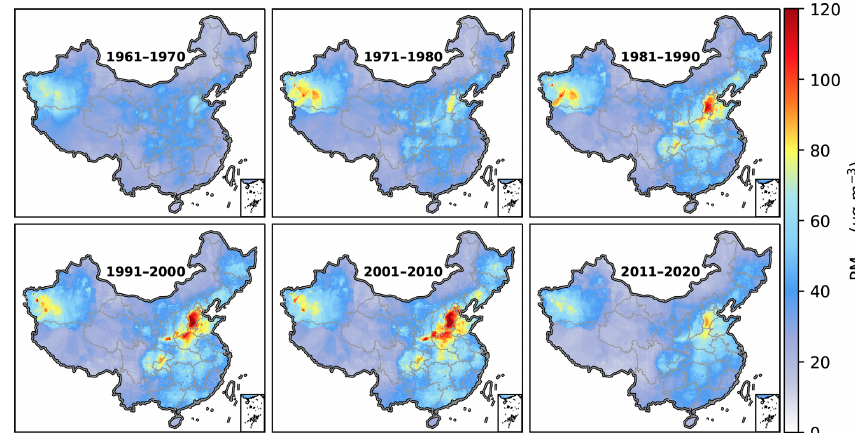
Figure 8. Gridded distribution of decadal average PM 2 . 5 mass concentration from 1960 to 2020.